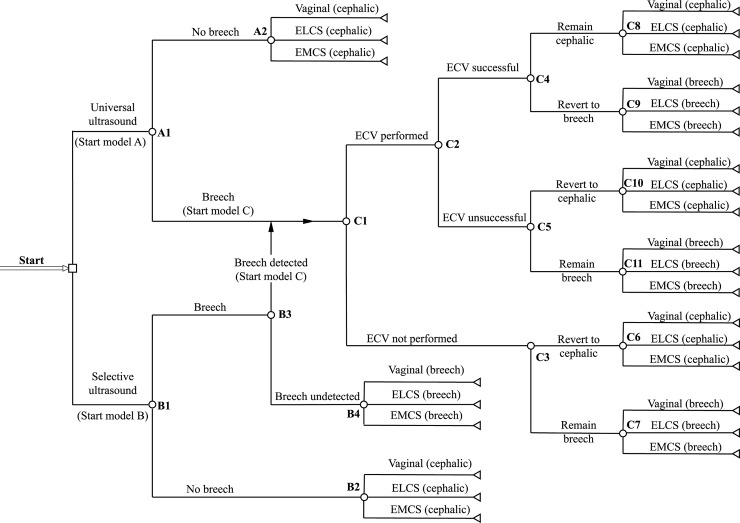
Simulation model structure.Structure of economic simulation model. ‘Universal ultrasound’ strategy starts in Model A, and patients with breech presentation enter Model C. ‘Selective ultrasound’, i.e., no routine ultrasound, starts in Model B, and only those with a detected breech presentation enter Model C. The letter–number codes for each node are equivalent to the codes in Table 1. ELCS, elective cesarean section; EMCS, emergency cesarean section.